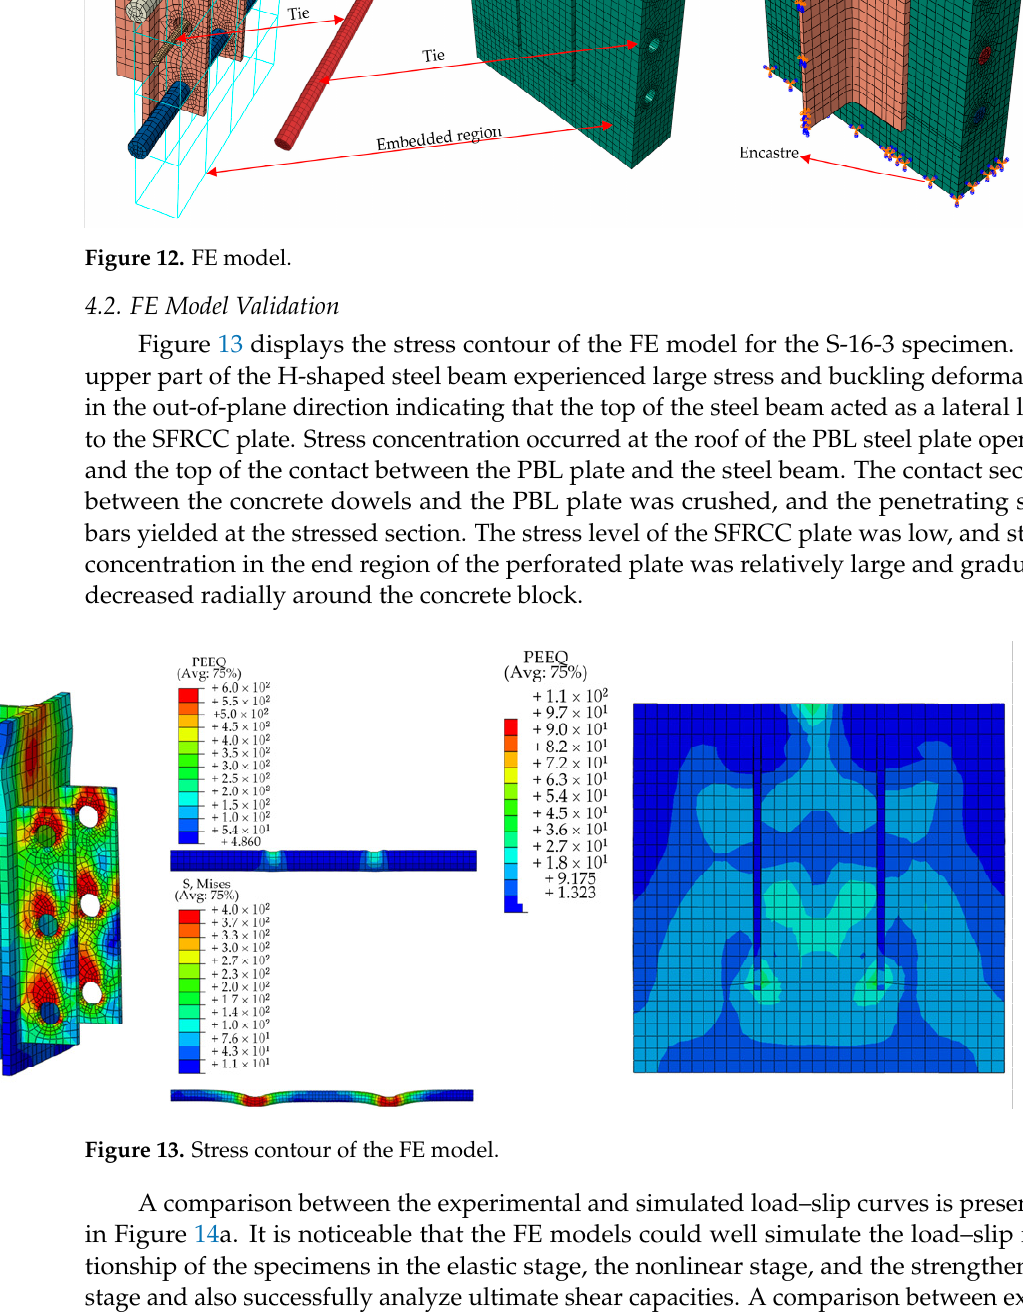
Figure 12. FE model.